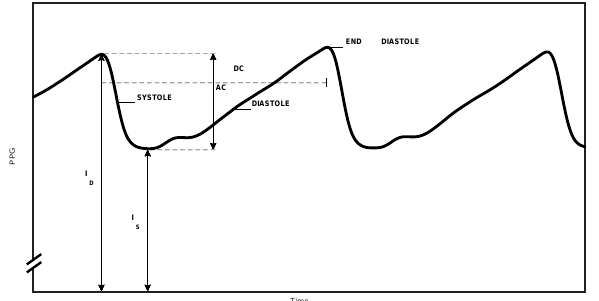
Figure 3. The measured parameters of the PPG pulses. The transmitted light through the tissue decreases during systole and increases during diastole. AC is the difference between the maximal (I D ) and minimal (I S ) light transmission through the tissue; DC is the mean light transmission during the pulse. This Figure was published in Yossef Hay et al. Sensors 2018 [41].